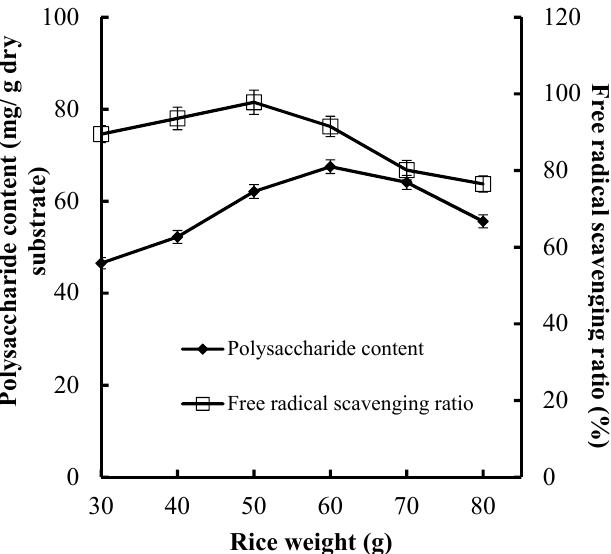
Figure 2. E ff ect of rice weight on CPS production and antioxidant activities of Figure 2. Effect of rice weight on CPS production and antioxidant activities of substrate.